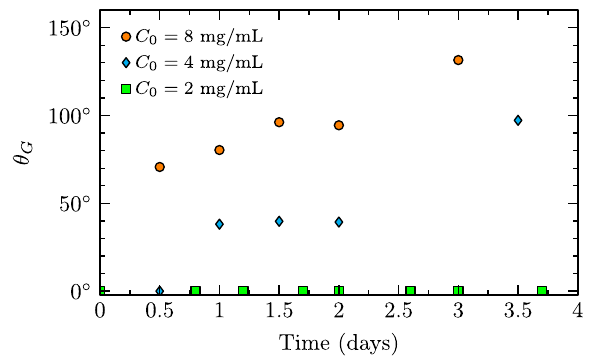
Fig. 7 Gelation front polar position, θ G , vs time for pre-sheared insulin cases. This data was extracted using the videos from which Fig. 6 was